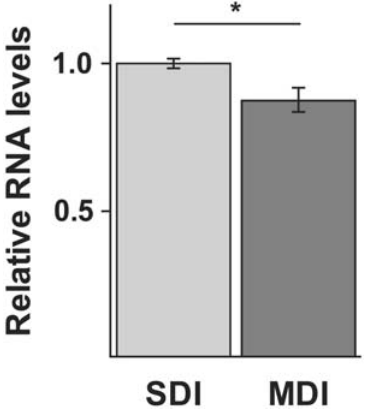
Figure 4. Brain gene expression levels are affected by insemination quantity. Expression levels of Amfor were monitored using quantitative real-time PCR using individual brains (SDI: N=9; MDI: N=9). SDI queens have significantly higher levels of Amfor than MDI queens (U=10, p=0.022). Data represent mean values, 2 / + standard error (converted to the same arbitrary scale as the mean), relative to the SDI